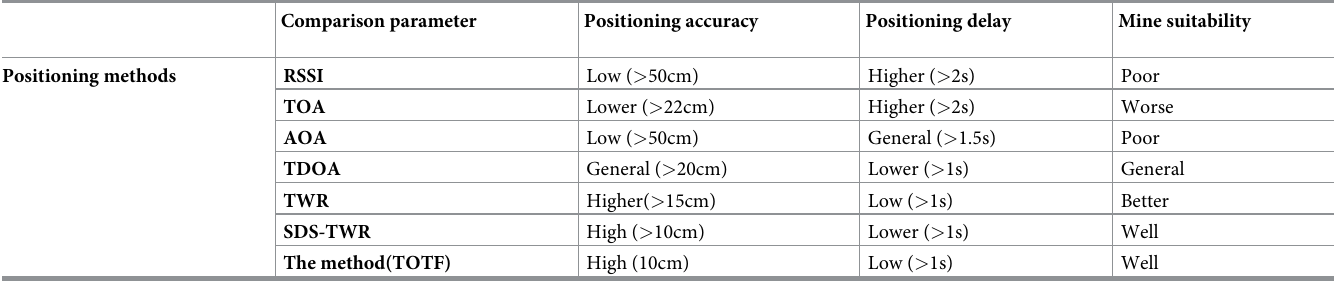
Table 6. Comparison between TOTF positioning methods and other underground mine personnel positioning